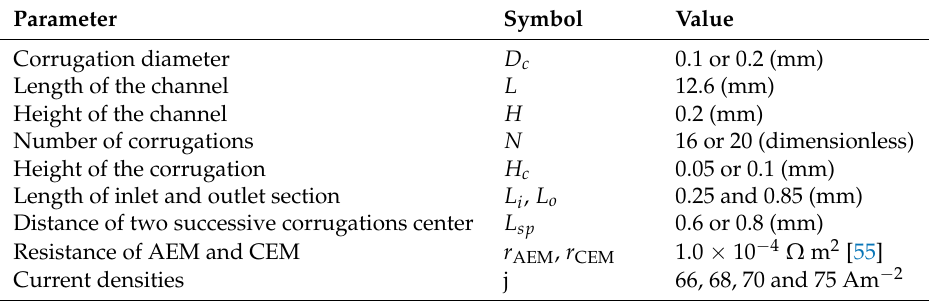
Table 3. Characteristic parameters of the studied geometries in factorial design and the input parameters. (The values of the current densities are dependent of the available area of the membranes for different topologies).